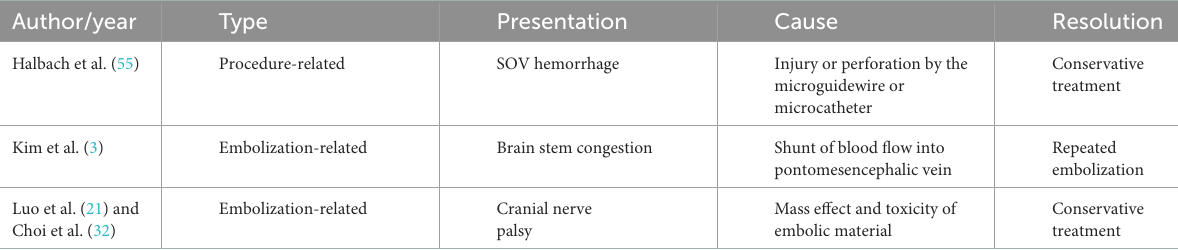
TABLE 1 Complication of the trans-FV-SOV route to embolize CS-DAVF.